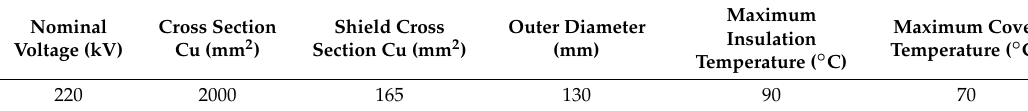
Table 3. Dimensional characteristics of 220 kV cable.